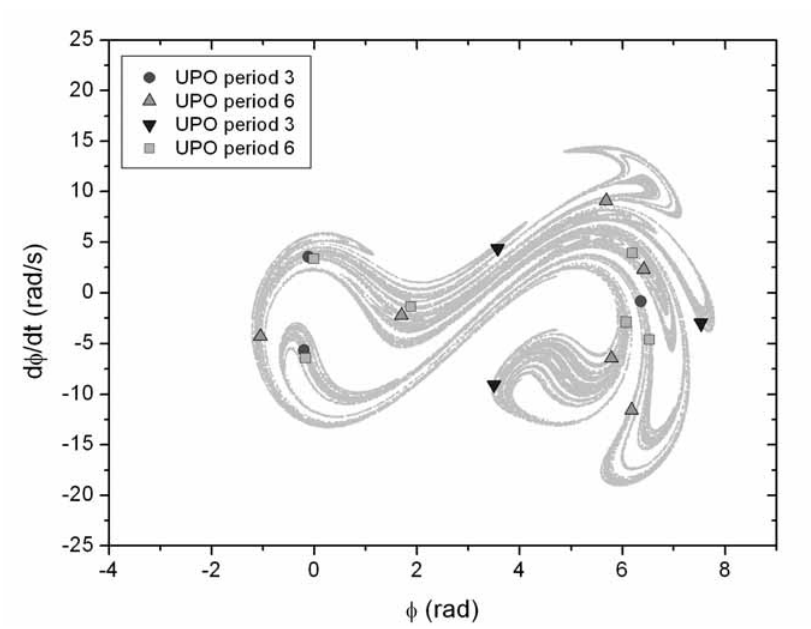
Fig. 8. Unstable periodic embedded in the reconstructed